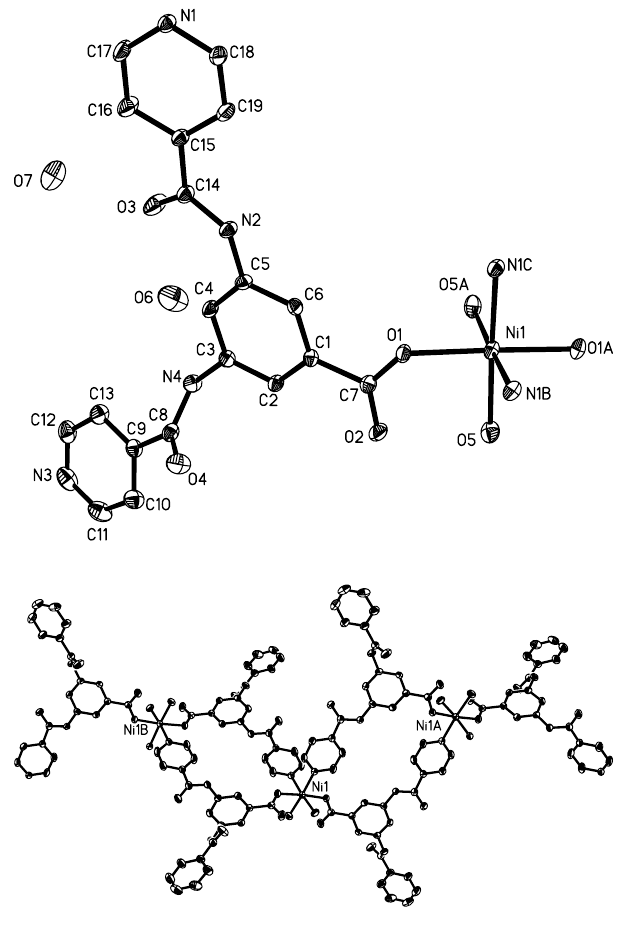
Table 1. Data collection and